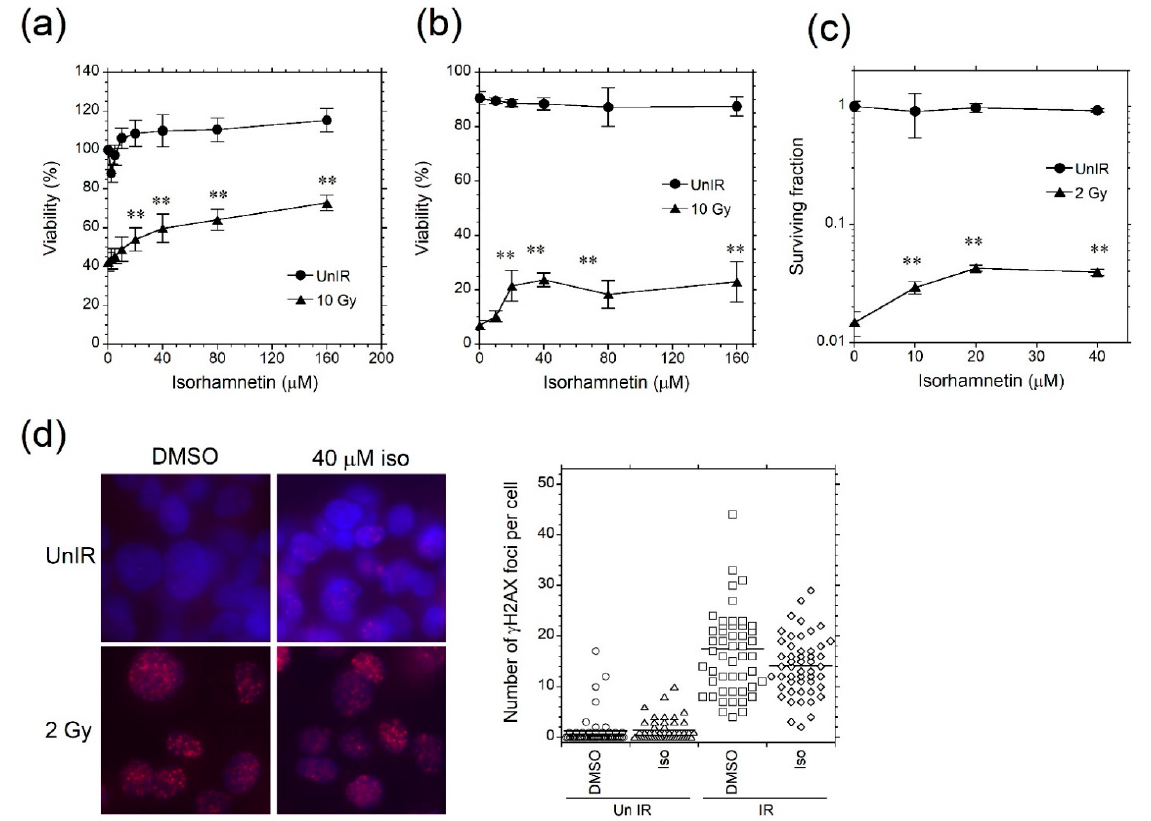
Figure 1. Isorhamnetin inhibits radiation-induced cell death. ( a ) WST-8 assay of MOLT-4 cell viability 24 h after 10 Gy irradiation ( n = 3). ( b ) Dye exclusion test of MOLT-4 cells 24 h after 10 Gy irradiation ( n = 3). ( c ) Colony forming activity of MOLT-4 cells treated with 2 Gy irradiation ( n = 5). ( d ) γ H2AX foci in Hep G2 cells 30 min after 2 Gy irradiation. The foci and DNA were stained with γ H2AX-specific antibody and DAPI, respectively. The number of γ H2AX foci per nucleus was quantified ( n = 50). Magnification, 40×. Data represent the mean ± standard deviation ( a – c ). Asterisk indicates a significant difference (** p < 0.01) between groups. DMSO dimethyl sulfoxide, Iso isorhamnetin, IR irradiated, UnIR unirradiated.